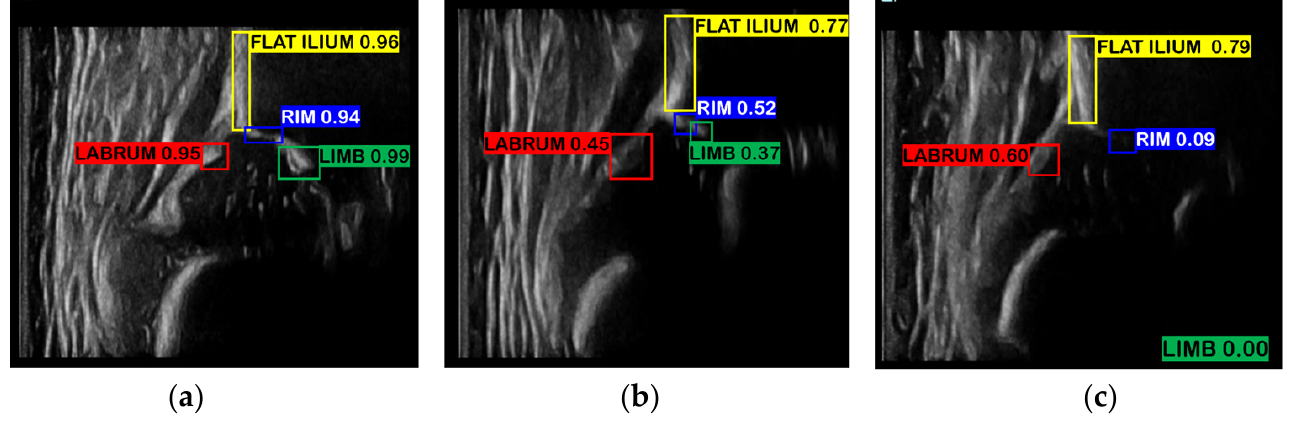
Figure 4. The network detection results. ( a ) Graf’s standard planes, where the anatomical structures are clear and visible for recognition, and can be accurately localized by the network, so they have high confidence scores. ( b , c ) Non-standard planes with unclear structures and low confidence scores. The lower limb of the os ilium cannot be recognized in ( c ), and thus the confidence score is 0.